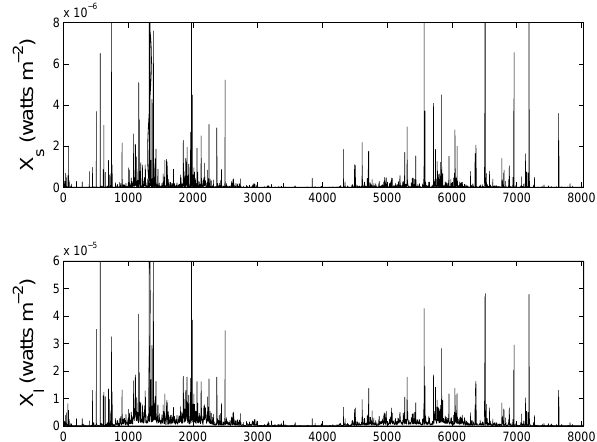
Fig. 1. The daily solar X-ray brightness, X l and X s , during the pe- riod from 1 January 1986 to 31 December 2007 which includes two solar cycles.